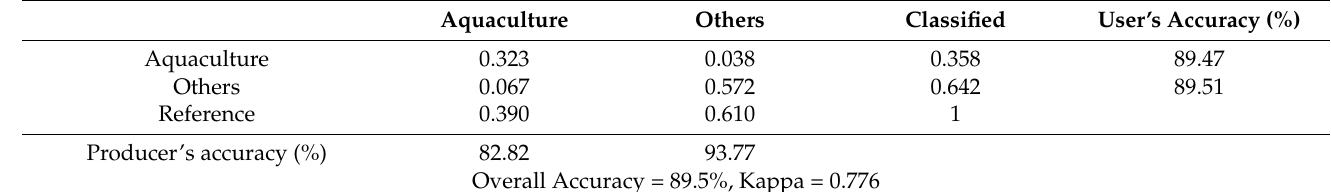
Table 4. Confusion matrix of proposed approach using 1000 validation samples.